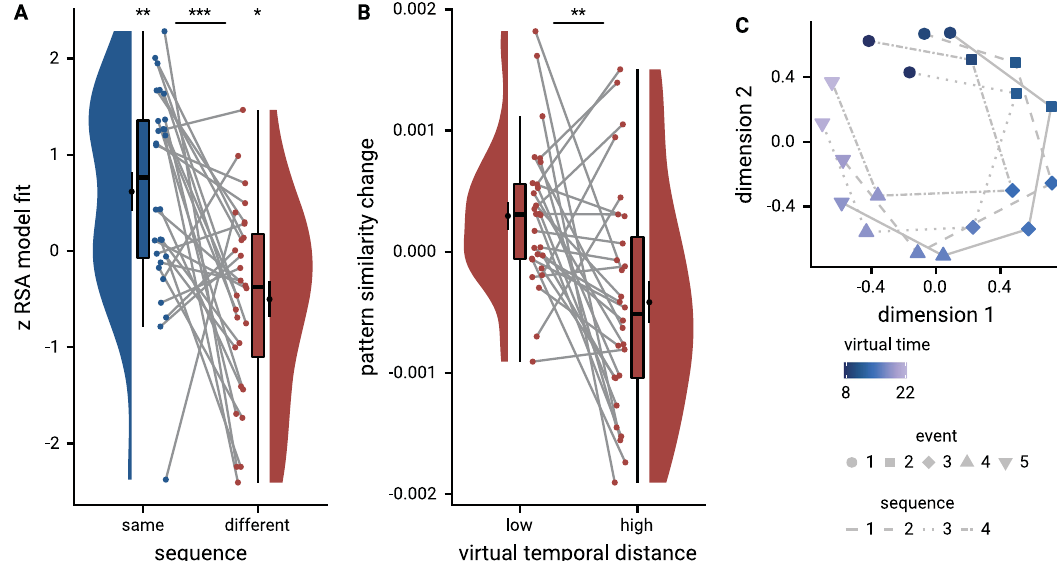
Fig. 5 The anterior hippocampus generalizes temporal relations across sequences. A Z-values show results of participant-speci fi c linear models quantifying the effect of virtual time for event pairs from the same sequence (blue, as in Fig. 4B) and from different sequences (red). Temporal distance is negatively related to hippocampal representational change for event pairs from different sequences. See Supplementary Fig. 4E, F for mixed model analysis of across-sequence comparisons. The effect of virtual time differs for comparisons within the same sequence or between two different sequences. B To illustrate the effect shown in A , average pattern similarity change values are shown for across-sequence event pairs that are separated by low and high temporal distances based on a median split. A , B . Circles show data from n = 28 participants; boxplots show median and upper/lower quartile along with whiskers extending to most extreme data point within 1.5 interquartile ranges above/below the upper/lower quartile; black circle with error bars corresponds to mean ± S.E.M.; distributions show probability density function of data points. ** p < 0.001; ** p < 0.01; * p < 0.05 C . Multidimensional scaling results show low-dimensional embedding of the event sequences. Shapes indicate event order, color shows virtual times of events. The different lines connect the events belonging to the four sequences for illustration. Source data are provided as a Source Data fi le. *** p ≤ 0.001; ** p < 0.01; * p <